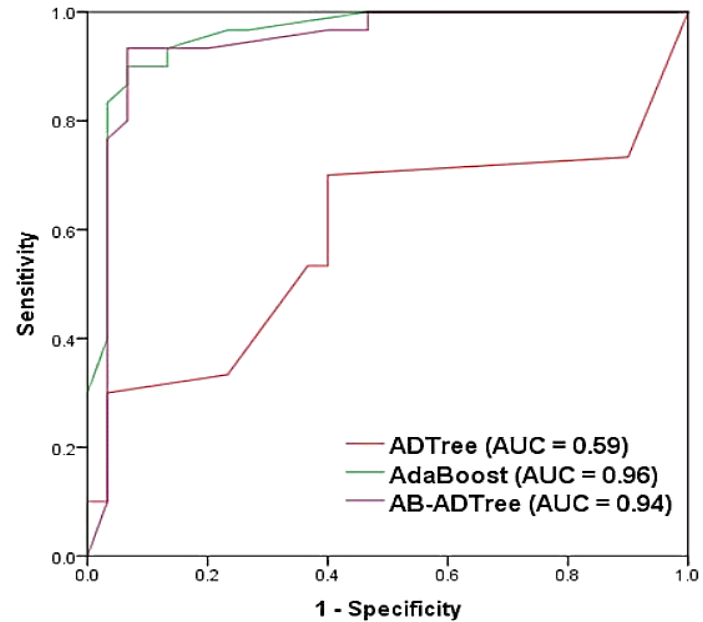
Figure 12. Receiver Operating Characteristic (ROC) curve and area under the receiver operating characteristic curve (AUC) values of the models using validation dataset. Table 4. Friedman test statistics results for this study.